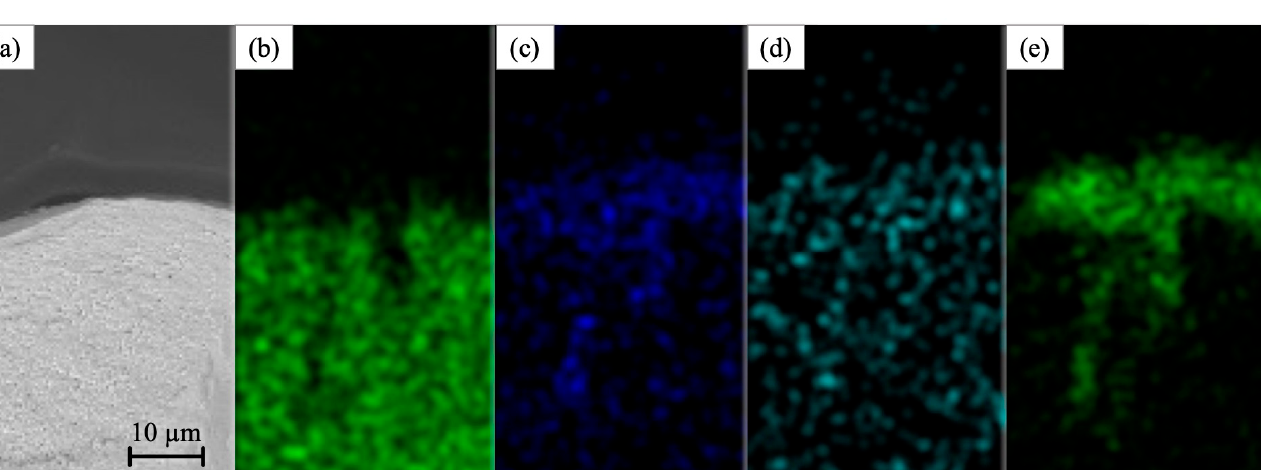
Figure 1. Algorithm for comparing the simulated and experimental frequency dependences of the impedance.